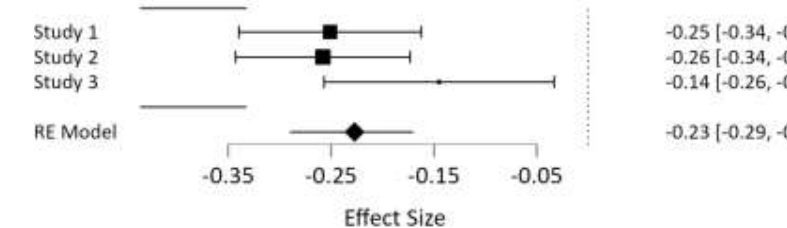
Figure 2. Forest plot of meta-analysis of Amotivation and Intellect